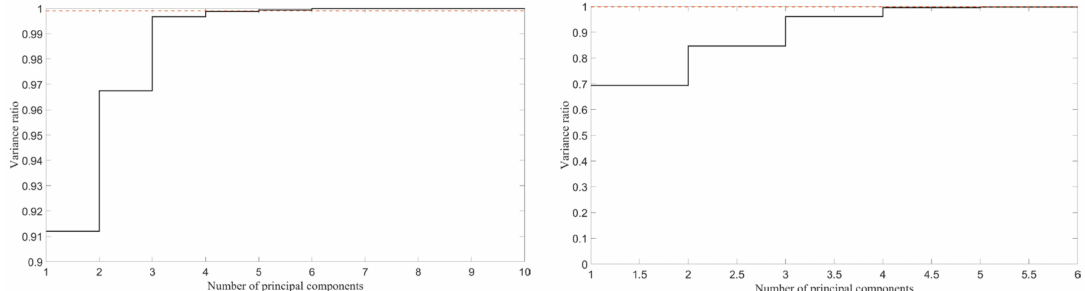
Figure 3. PCA downscaling results (( left ): one input variable, ( right ): four input